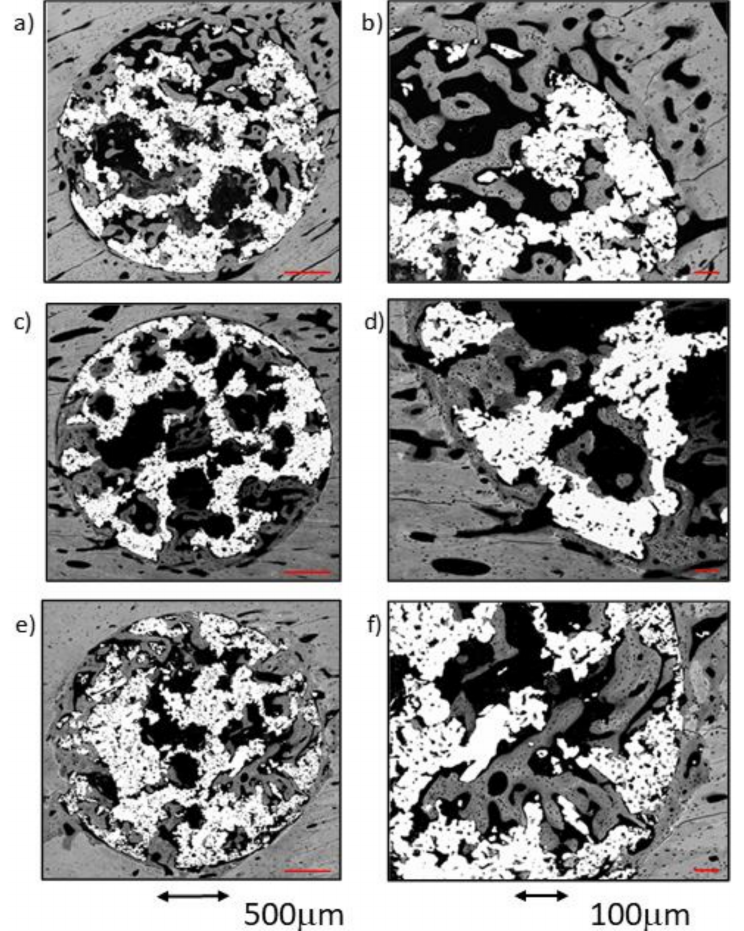
Figure 5. BSE-SEM micrographs 4 weeks after implantation in transversal section view at different magnifications: ( a , b ) CG; ( c , d ) TCG; ( e , f )